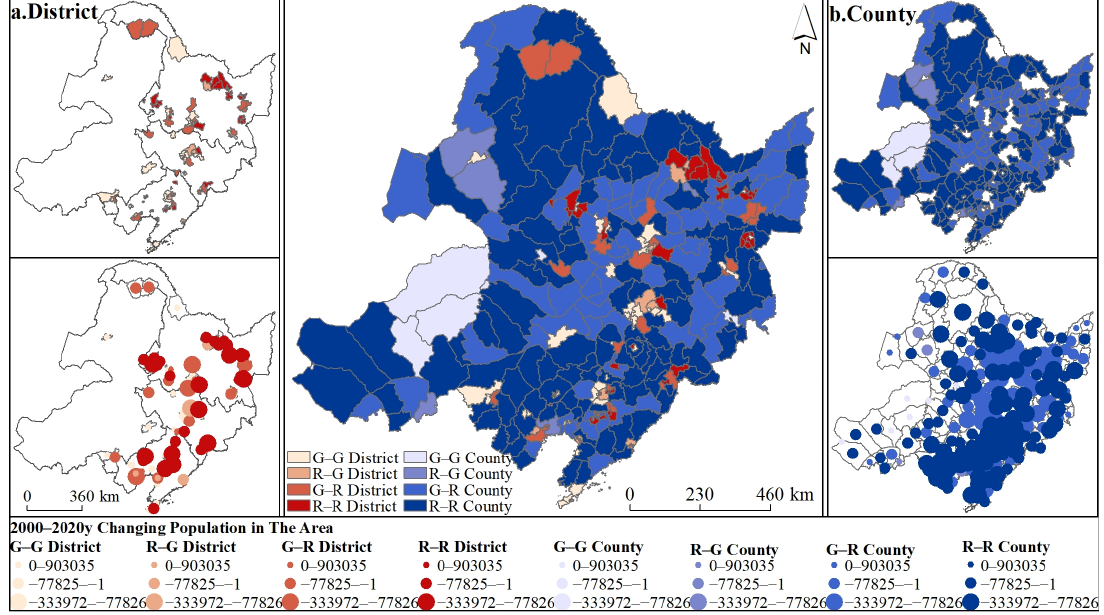
Figure 4. Study area county and district population change classification. ( a ) District; ( b ) county.